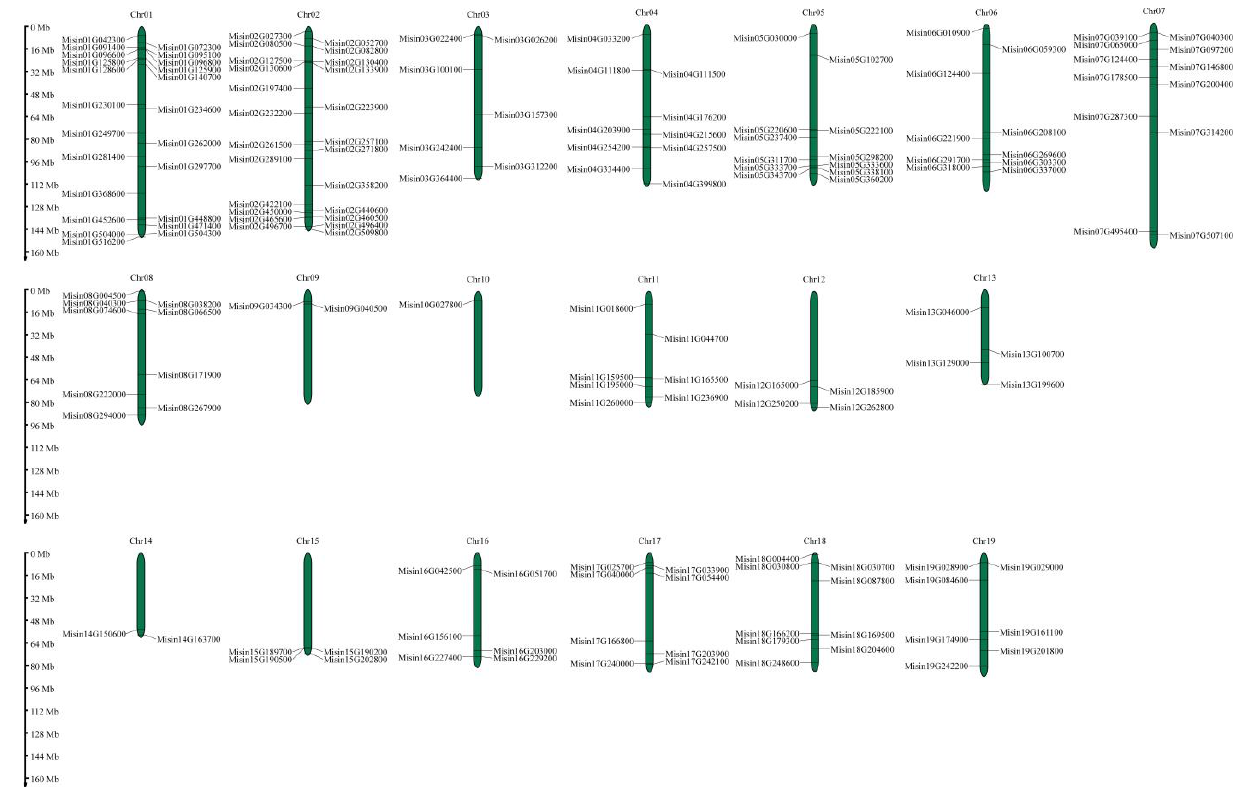
Figure 3. Distribution of 169 HD-Zip genes on 19 M. sinensis chromosomes, represented by vertical bars, with chromosomes numbered at the top. On the left, the scale represents chromosome length in megabytes (Mb).